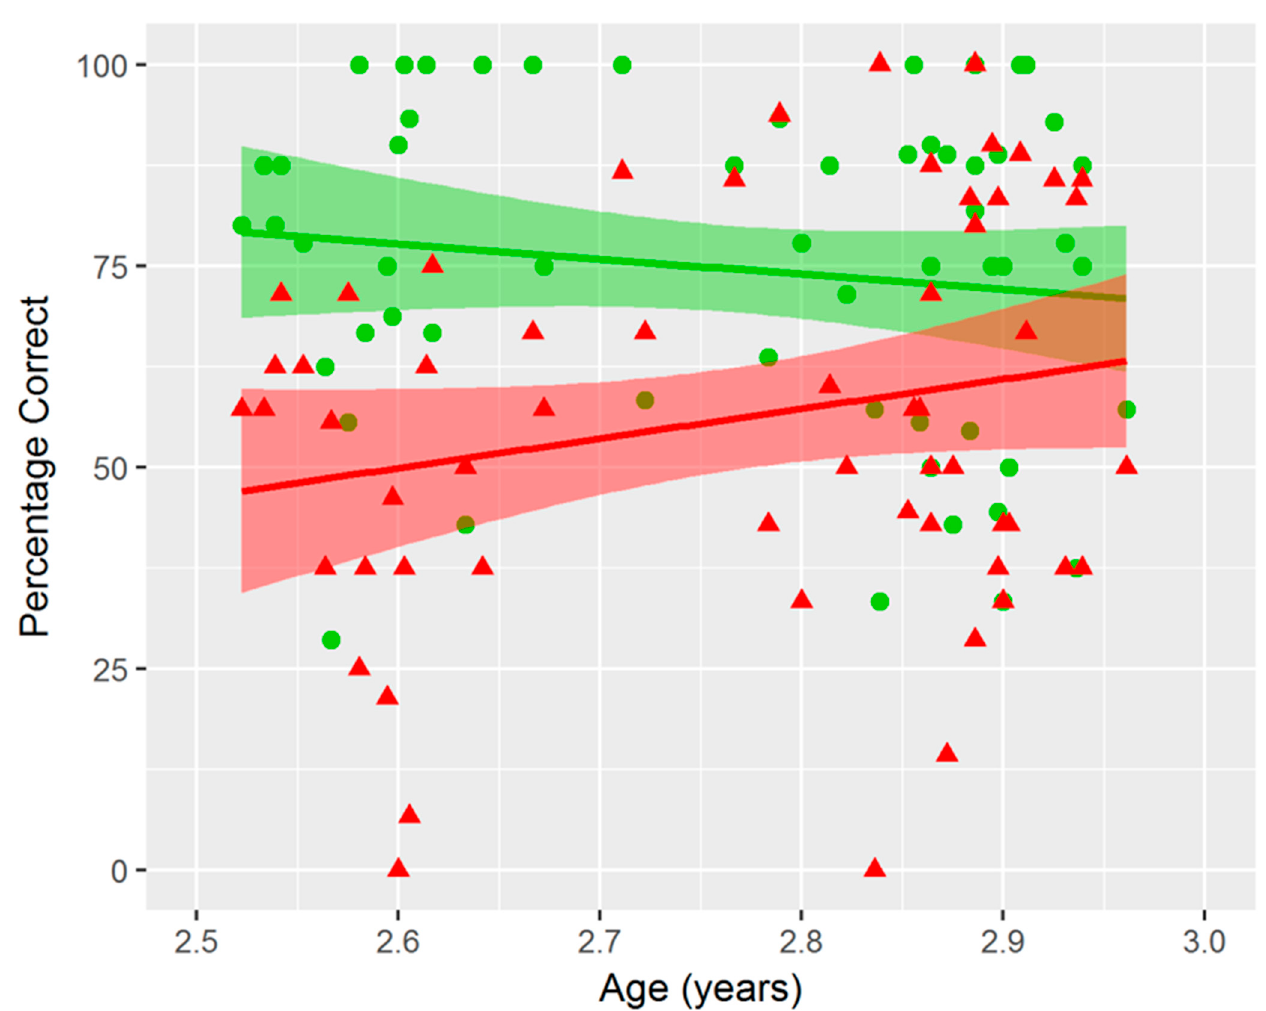
Figure 3. Main analysis results per subject for Congruency by Age on Percentage Correct . SCon means are represented in green circles, SIncon means in red triangles. Lines represent the regression lines, shaded area represents standard errors (SCon in green, SIncon in red).